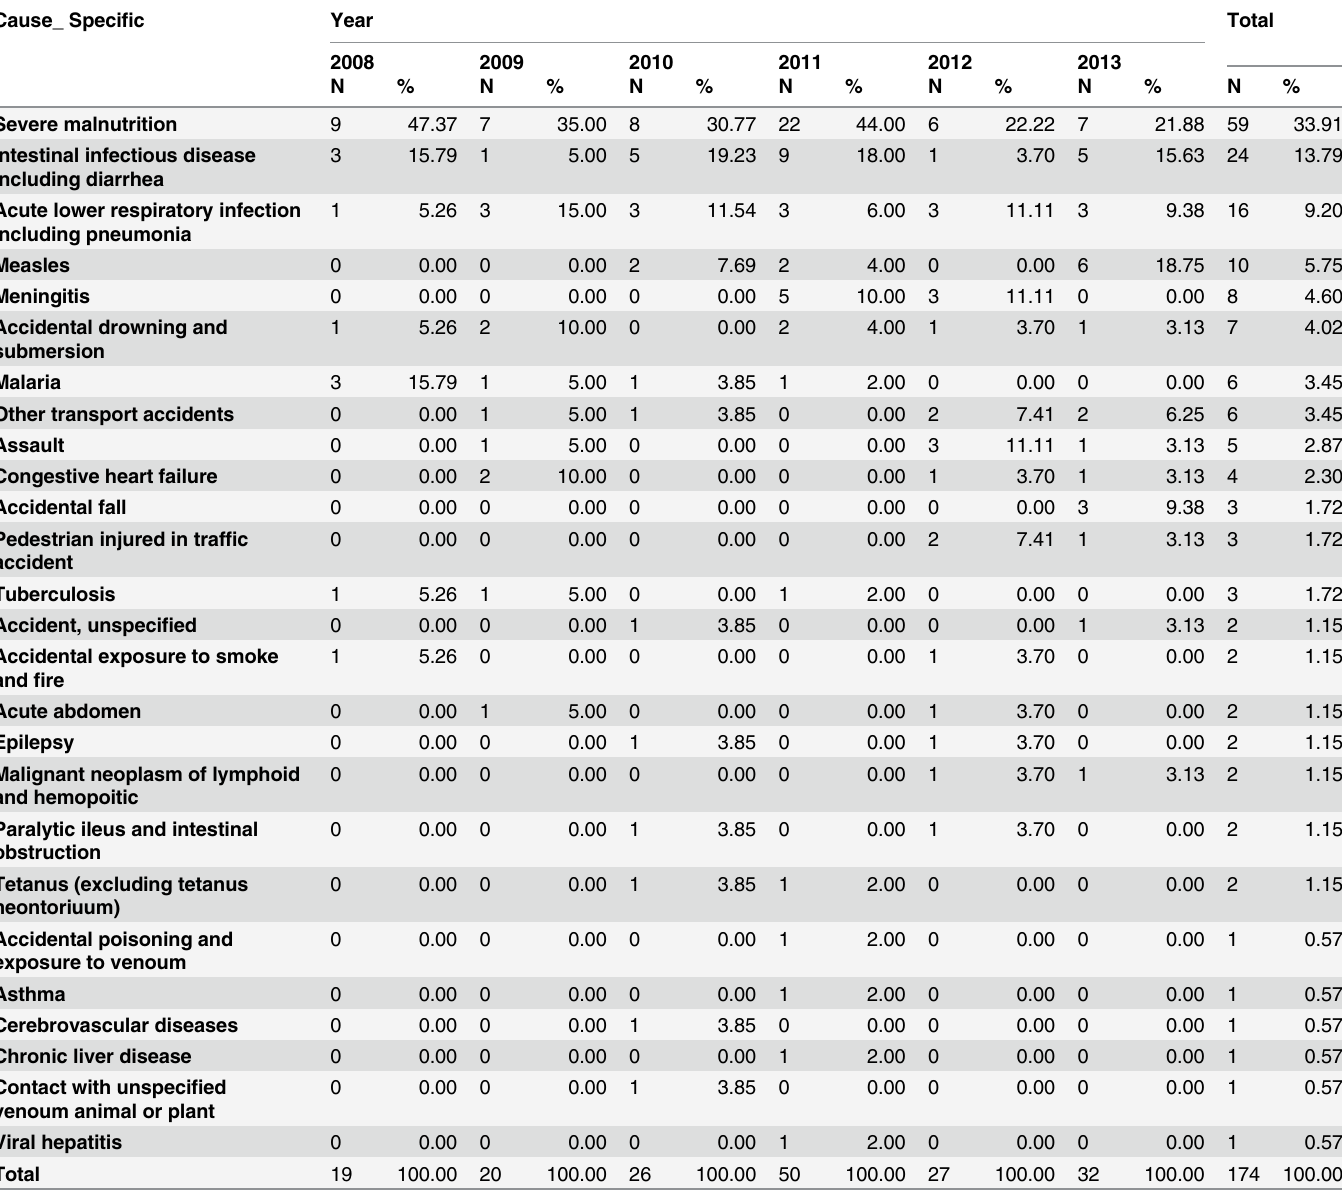
Table 3. Major specific causes of death by year among children aged 5 – 14 years, Kersa HDSS, 2008 –